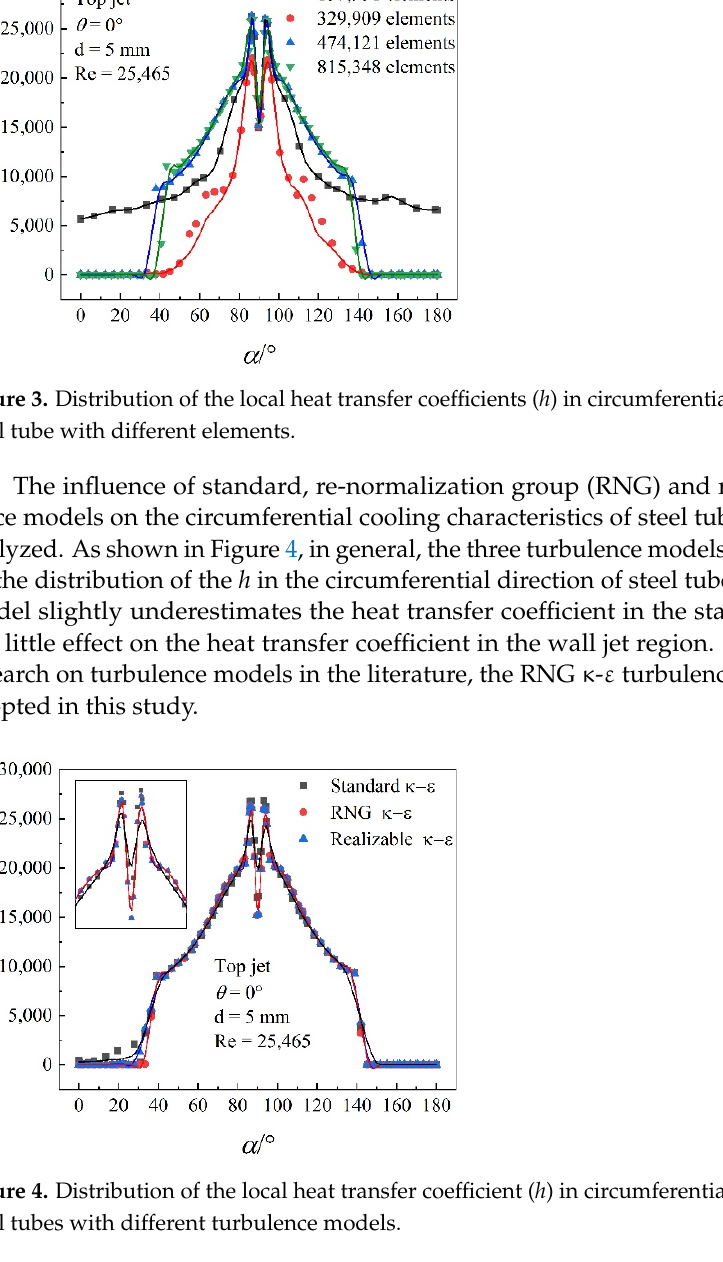
Figure 5. Flow field distribution velocity contour of top jet impacting cooling steel tube. ( a ) θ = 0°; ( b ) θ = 10°; ( c ) θ = 20°; ( d ) θ = 30°.